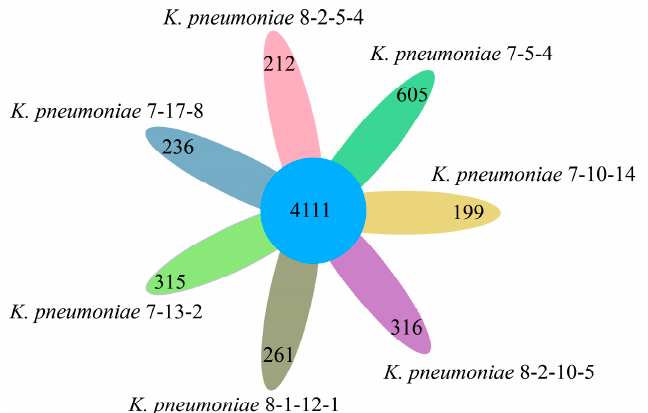
Figure 7. The Venn diagram showing the number of core genes and strain-speci fi c genes in the seven K. pneumoniae